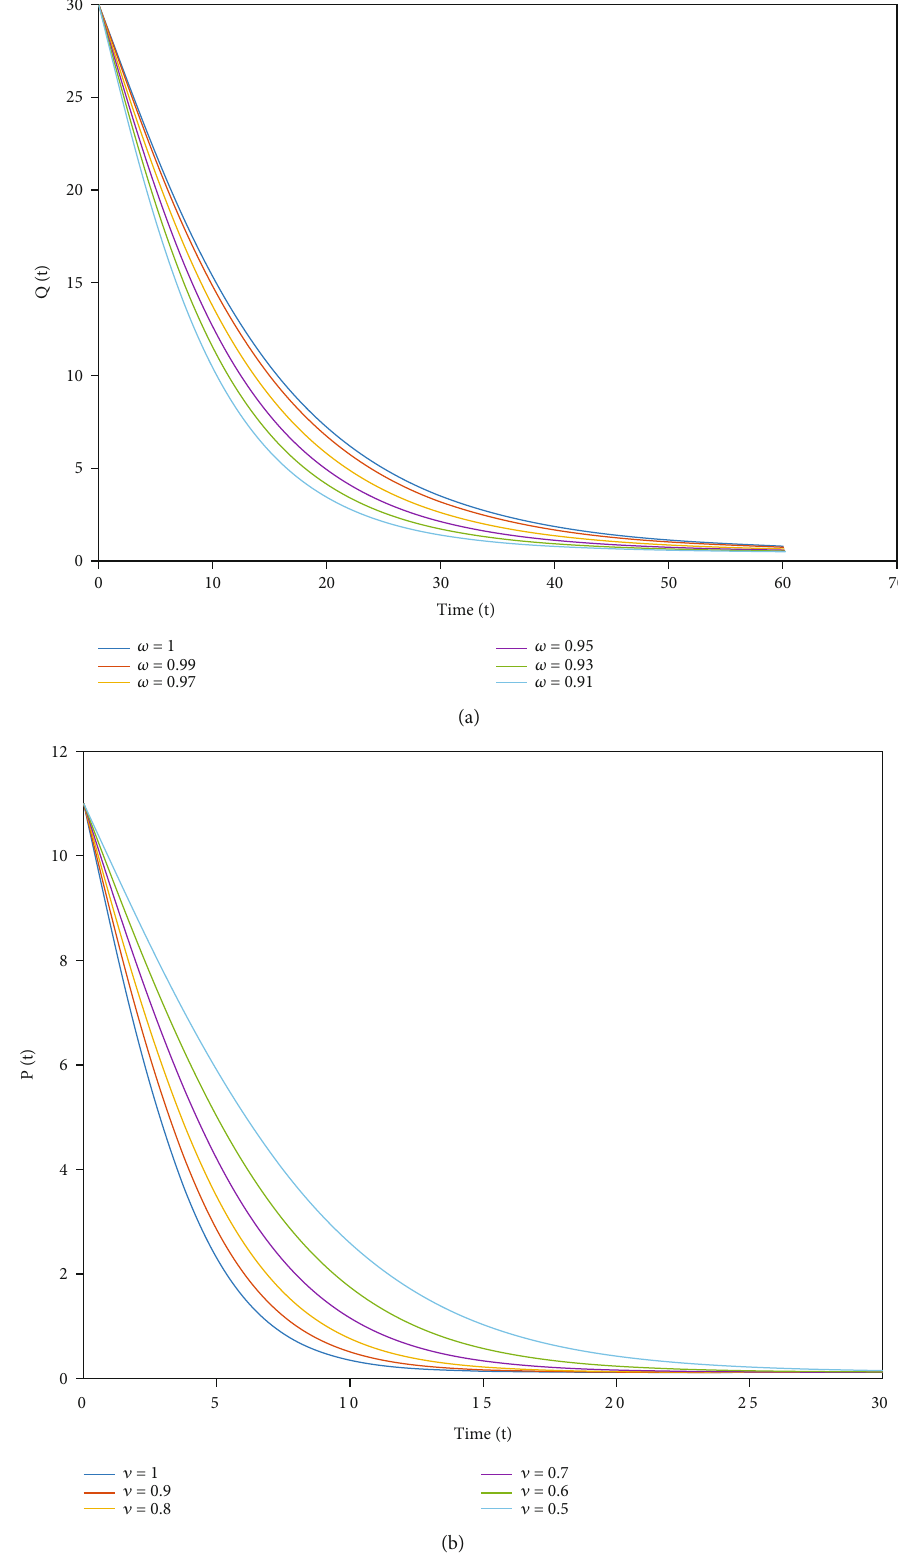
Figure 9: (a) The simulation of the function Q ð t Þ during the time t for di ff erent fractional orders ω = 1,0 : 99,0 : 97,0 : 95,0 : 93,0 : 91 and fractal dimension ν = 0 : 99 . (b) The simulation of the function P ð t Þ during the time t for di ff erent fractal dimensions ν = 1,0 : 9,0 : 8,0 : 7,0 : 6,0 : 5 and fractional order ω = 0 : 97